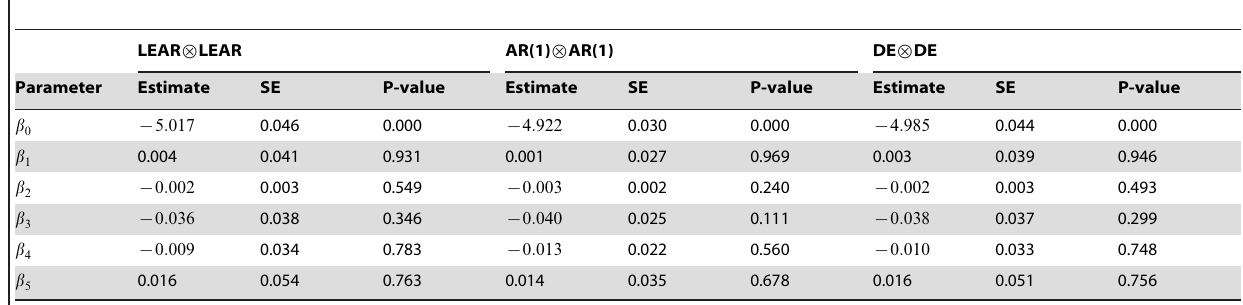
Table 4. Initial full mean model estimates, standard errors, and